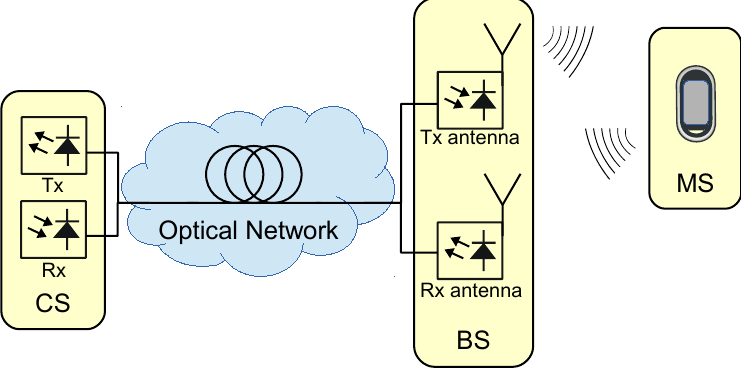
Figure 1. RoF–FTTA system overview: Central Station (CS), Optical Fiber Network, Base Station (BS) with fiber-coupled Rx antenna and Mobile Station